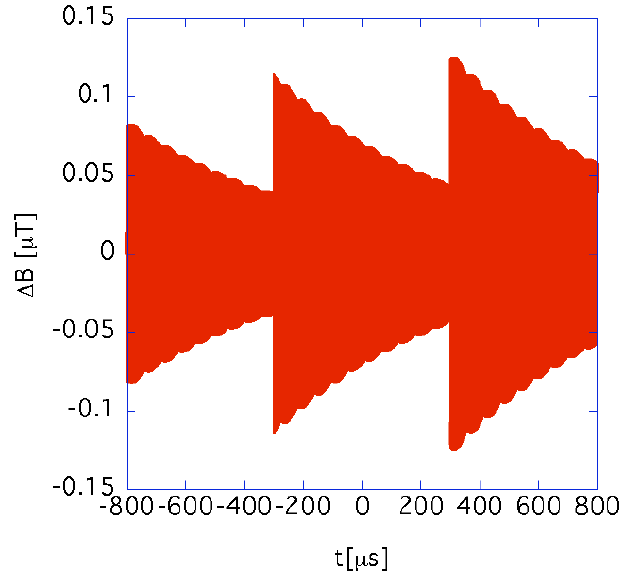
FIG. 17. (Color) The field modulation at the center of the chamber due to the current of only a single coil in an open space, which is specified with index ID ¼ 1 . As a typical parameter, capacitance C ¼ 0 : 3 (cid:5) F . The other parameters are the same as those in the right of Fig. 14.